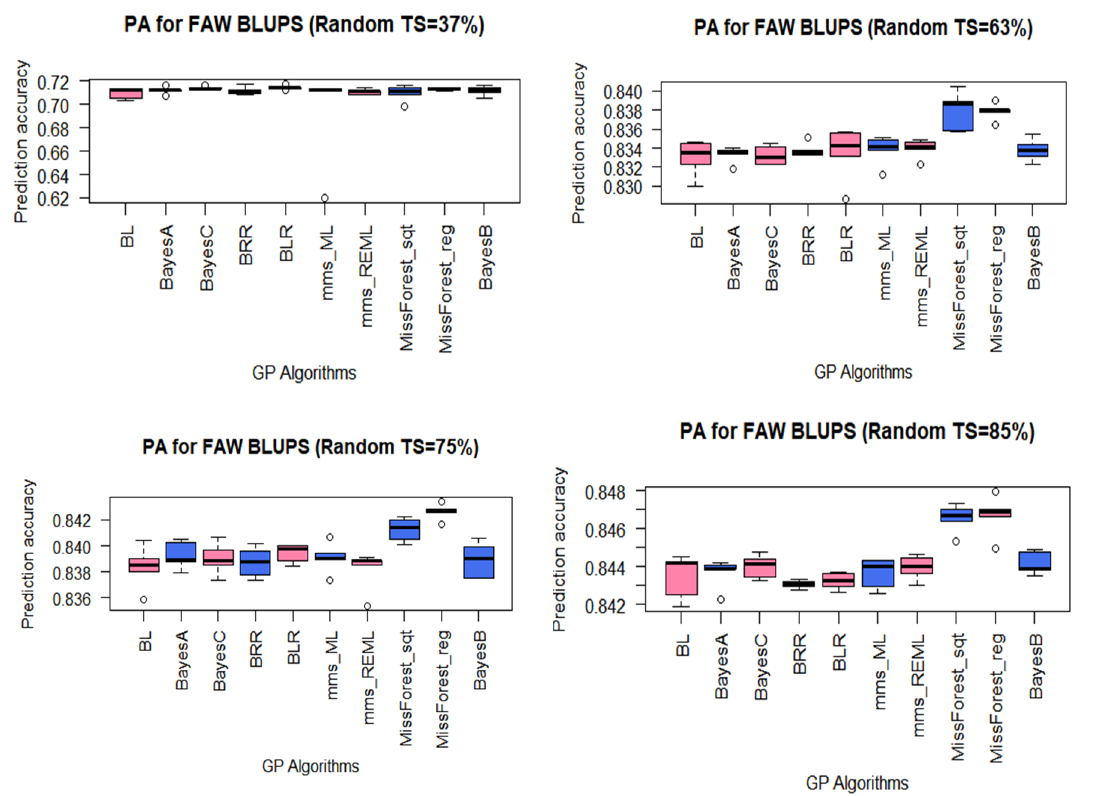
Figure 3. Boxplot of PAs for maize resistance to the fall armyworm (FAW) datasets with the RBTS approach with random selection of 37, 63, 75, and 87% of the entire panel (see Table 3 for GP algorithms).